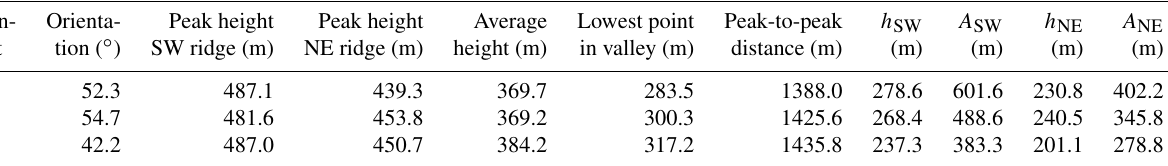
Table 2. Parameters describing the measurement transects. Peak height gives the highest points at the southwest (SW) and northeast (NE) ridges, respectively. The average terrain elevation is measured along the transects in between the peaks. The maximum height of the ridges relative to the terrain height at the transect before and after the ridges is given by h SW and h NE . A SW and A NE is the half width at half height of the faces inside the valley.